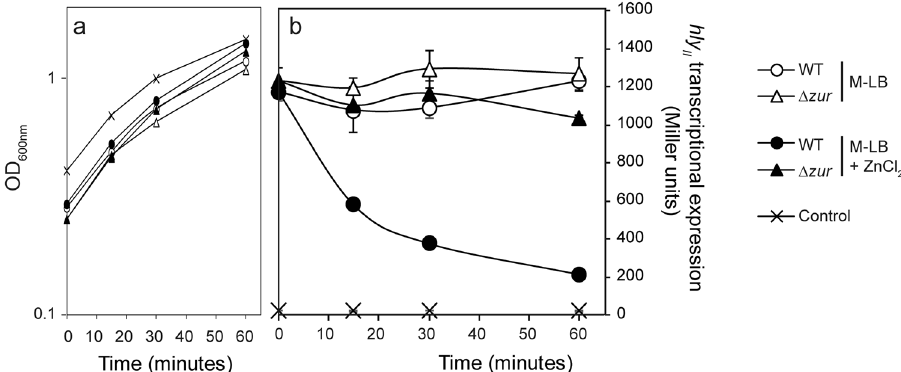
Figure 5. Rapid response of hly II transcriptional expression to zinc addition. ( a ) Growth curves of the strain JFV3 and EV46 ( zur:: Cm R ) in the indicated media by measuring OD 600 nm from two independent cultures; mean values are plotted. ( b ) Transcriptional expression of hly II in cultures of JFV3 and EV46 after zinc addition. Cultures were grown in M-LB up to an OD 600 nm of 0.3 when media was either replenished or not with 10 μ M ZnCl 2 . Culture samples were taken right before ZnCl 2 addition (0 minutes), and after 15, 30 and 60 minutes. As a control, JFV3 was cultured in M-LB replenished with 10 μ M ZnCl 2 from the beginning. β -galactosidase activity (expressed in Miller units) was determined from three independent cultures; mean values with standard deviation are plotted.